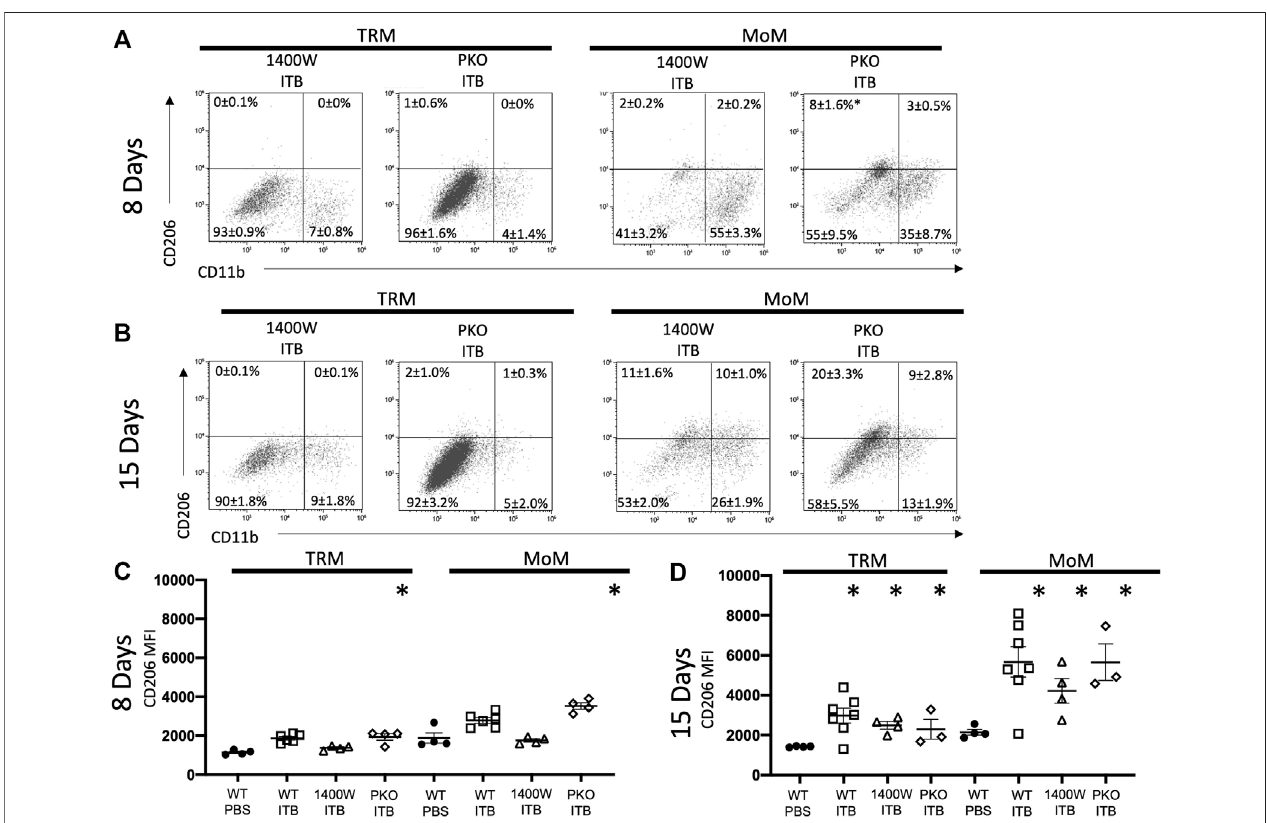
FIGURE9| SystemiciNOSinhibitionandpulmonaryspeci fi ciNOSknockoutshaveanalteredresponsetoITB.Followingbleomycininstillation,macrophageswere assessed from 1400 Wtreatedand PKOmice. (A – B) Macrophageswereidenti fi edasTRMsandMoMs basedonGFPexpression 8 (A) and 15 (B) dayspostinstillation insingleliveF4/80+cells.Themeanpercentage ±SEforeachquadrantisreported. (C – D) CD206expression isreportedasmean fl uorescence intensity(MFI)8 (C) and 15 (D) days post instillation. ( n = 3 – 7 per group) * p < 0.05 compared to PBS, + < 0.05 compared to